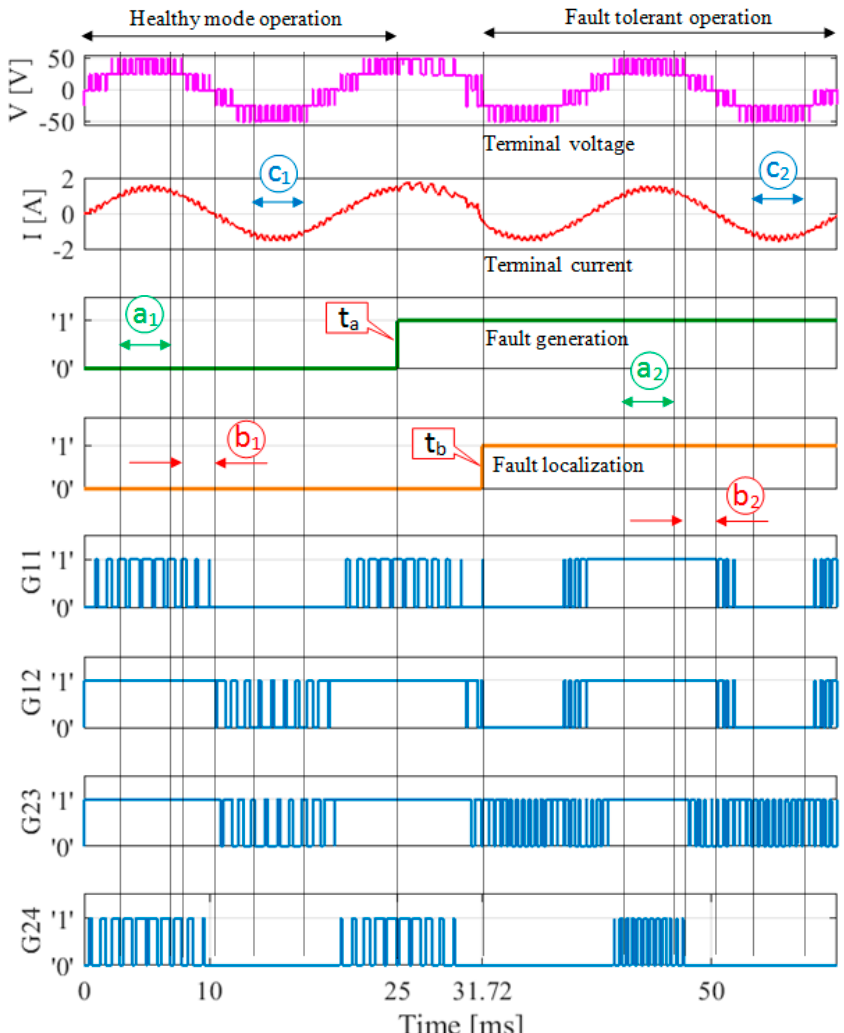
Figure 4. Simulation results for fault-tolerant operation of the inverter in the case of a short-circuit fault event in S11.